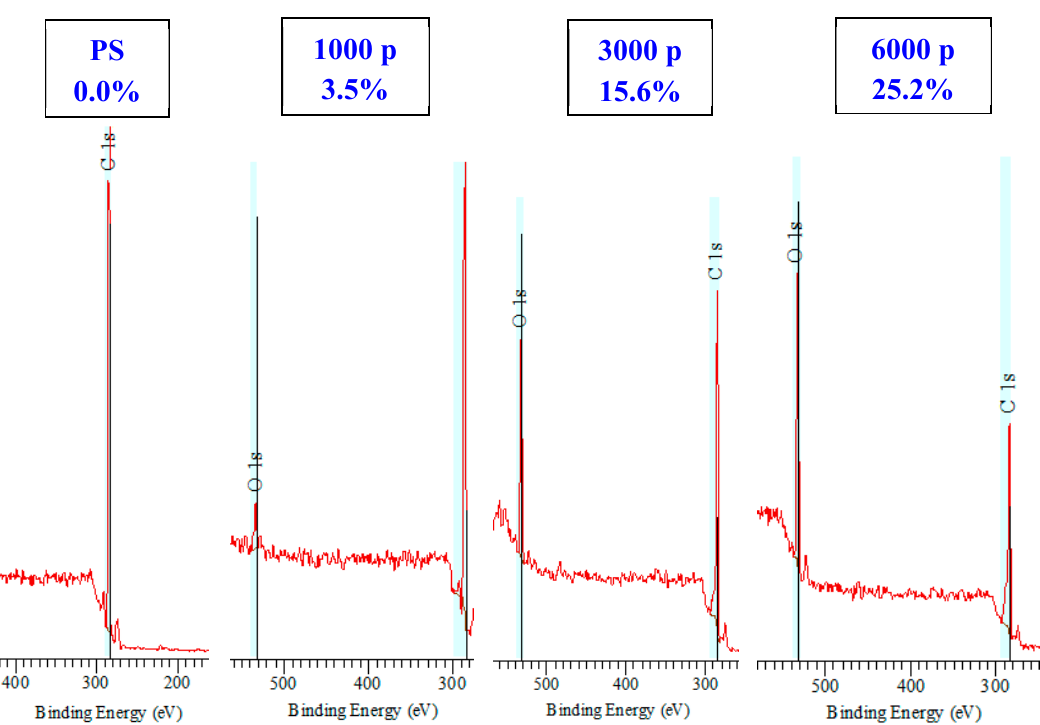
Figure 7. XPS spectra of pristine and laser-treated polystyrene. The laser exposure of 10 mJ·cm − 2 with 1000, 3000, and 6000 pulses was applied. The oxygen atomic concentrations are introduced for particular samples. Table 1. Oxygen atomic concentrations for pristine and laser-treated polystyrene, polyethylene naphthalate, and polyethersulfone acquired from XPS spectra. The laser exposure of 10 mJ · cm − 2 with 1000, 3000, and 6000 pulses was